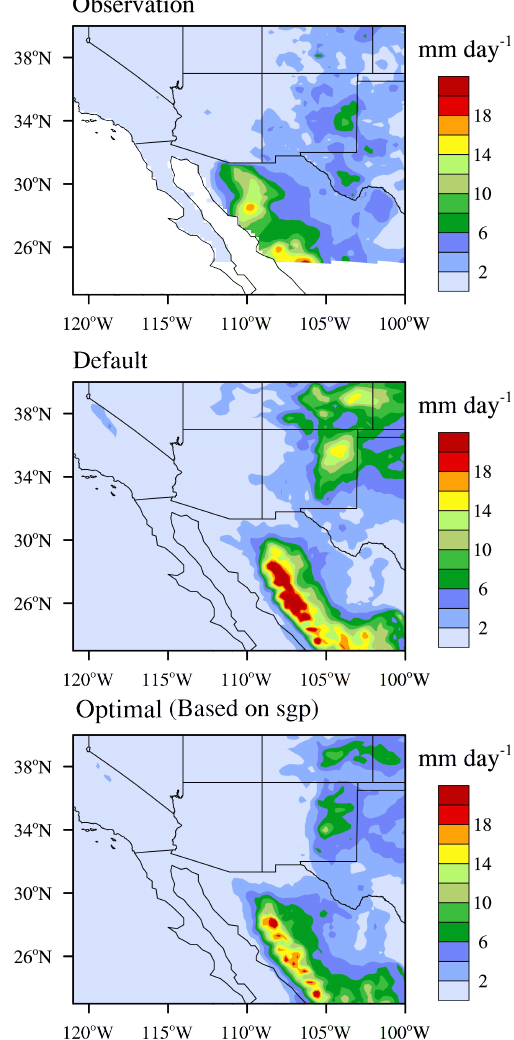
Fig. 12. The spatial distributions of observed and WRF simulated (with 12-km spatial resolution) monthly mean precipitations over SGP for June 2007, with default and optimal parameters based on 25-km simulation.